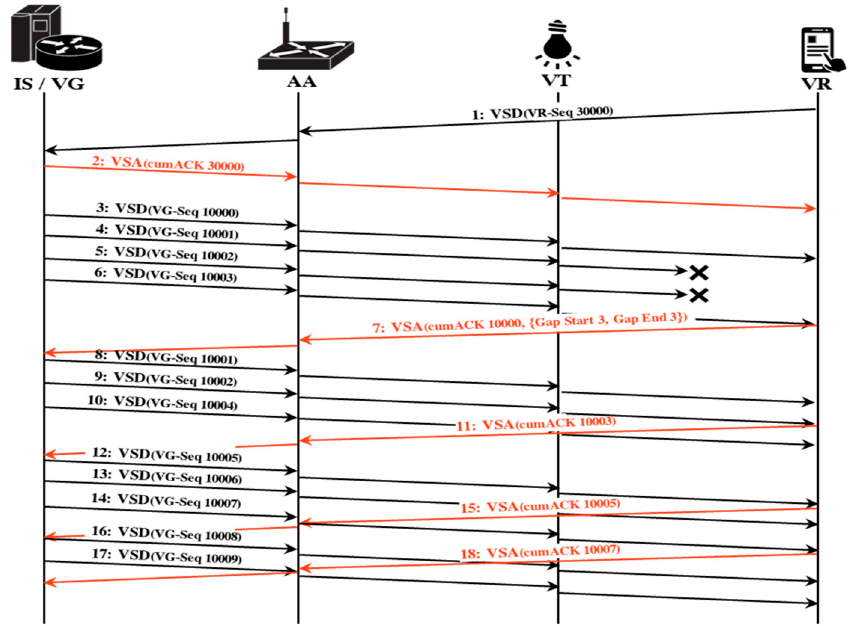
Figure 13. Data retransmission operations by loss detection with Gap ACK.